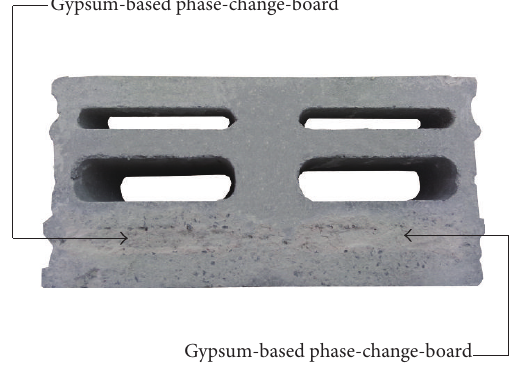
Figure 2: The actual object of block with